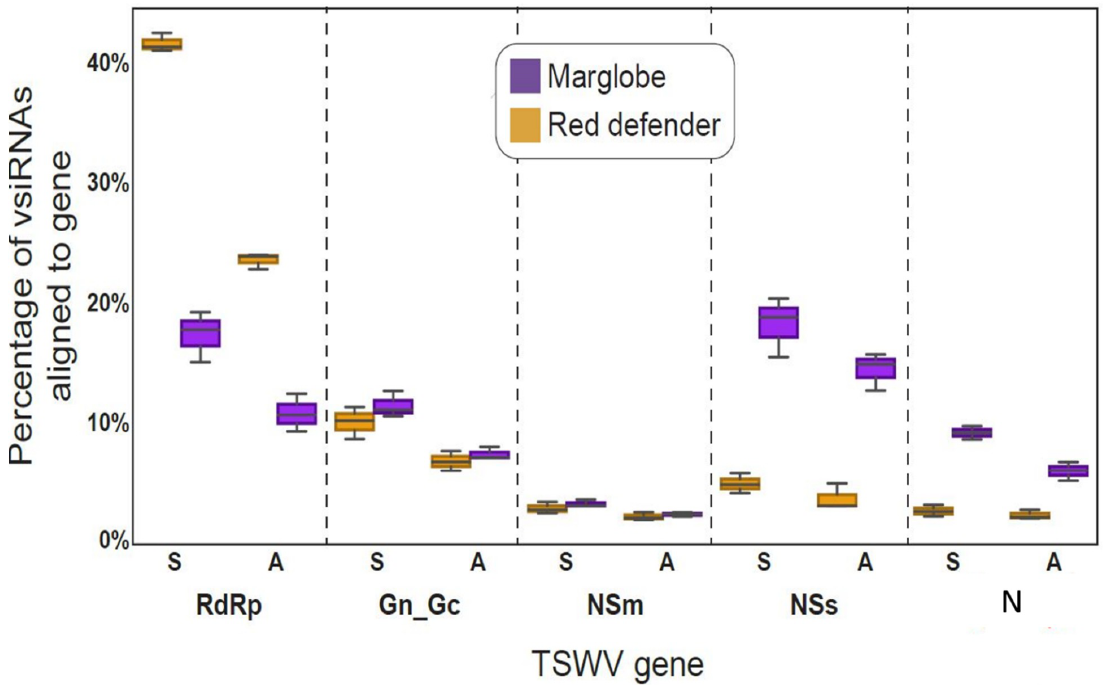
Figure 5. Boxplots of the percentage of viral-derived small interfering RNAs (vsiRNAs) aligned to each tomato spotted wilt virus (TSWV) gene in the tomato cv. Red Defender, Sw -5( + ) and Sw -5( − ) (cv. Marglobe). The smoothed plots are standard error for each range. RdRp: Polymerase gene; G N / G C : Glycoprotein precursor gene; NSm, Movement gene; NSs: silencing suppressor gene; N: Nucleoprotein gene. S: sense, A: antisense. Purple corresponds to tomato cv. Marglobe, the susceptible genotype Sw -5( − ), while the yellow line corresponds to cv. Red Defender, the resistant genotype, Sw -5( + ). ANOVA analysis followed by Tuckey HSD test ( p -value <0.05).